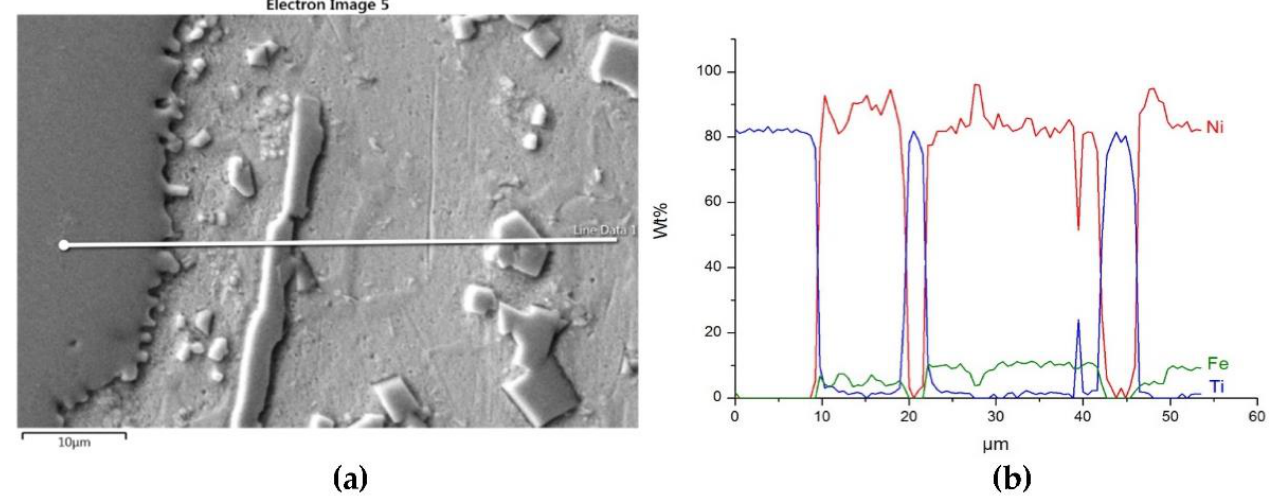
Figure 9. Structure close to the Ni alloy − TiC interfacial boundary ( a ) and concentrations of elements along the marked line ( b ).